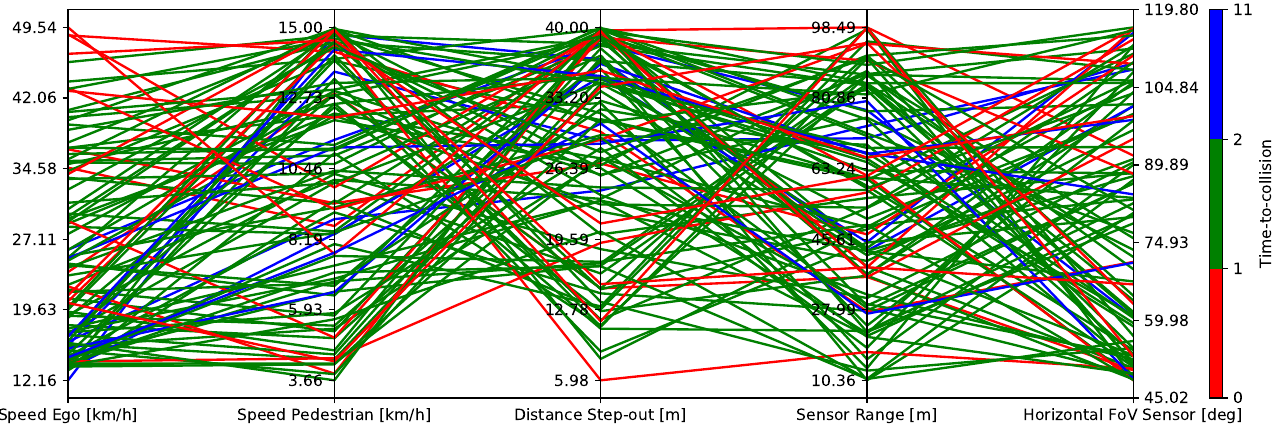
Figure 4. Combinations of scenario parameters of critical scenarios for the pedestrian step-out